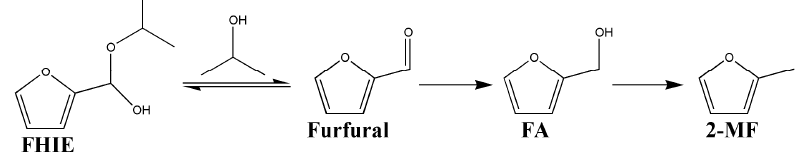
Figure 1. Scheme of furfural hydrogenation over calcined catalyst MoC–SiO 2 (700) at T = 150 ◦ C, 6.0 MPa, m cat = 1.000 g, and furfural/isopropanol molar ratio equal to 0.033. P = 6.0 MPa, m cat = 1.000 g, and furfural/isopropanol molar ratio equal to 0.033.